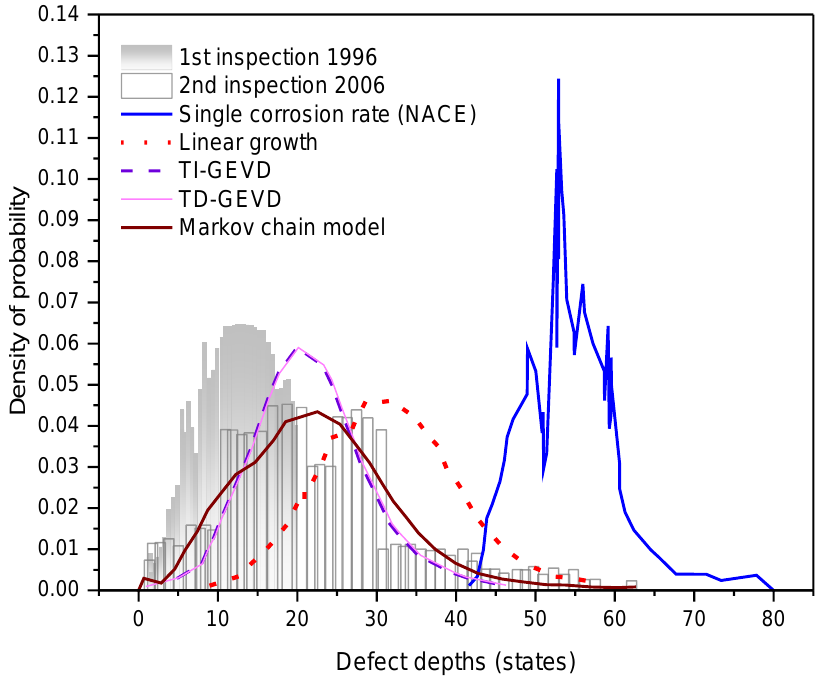
Figure 10. Exemplification of corrosion defect depth distributions obtained by five theoretical models and their comparison with empirical data obtained by ILI. This figure was modified (histogram bin width and colors in lines and bins were changed) using data from research conducted by Valor and coworkers reprinted with permission from ref. [93]. Copyright 2022 Elsevier.